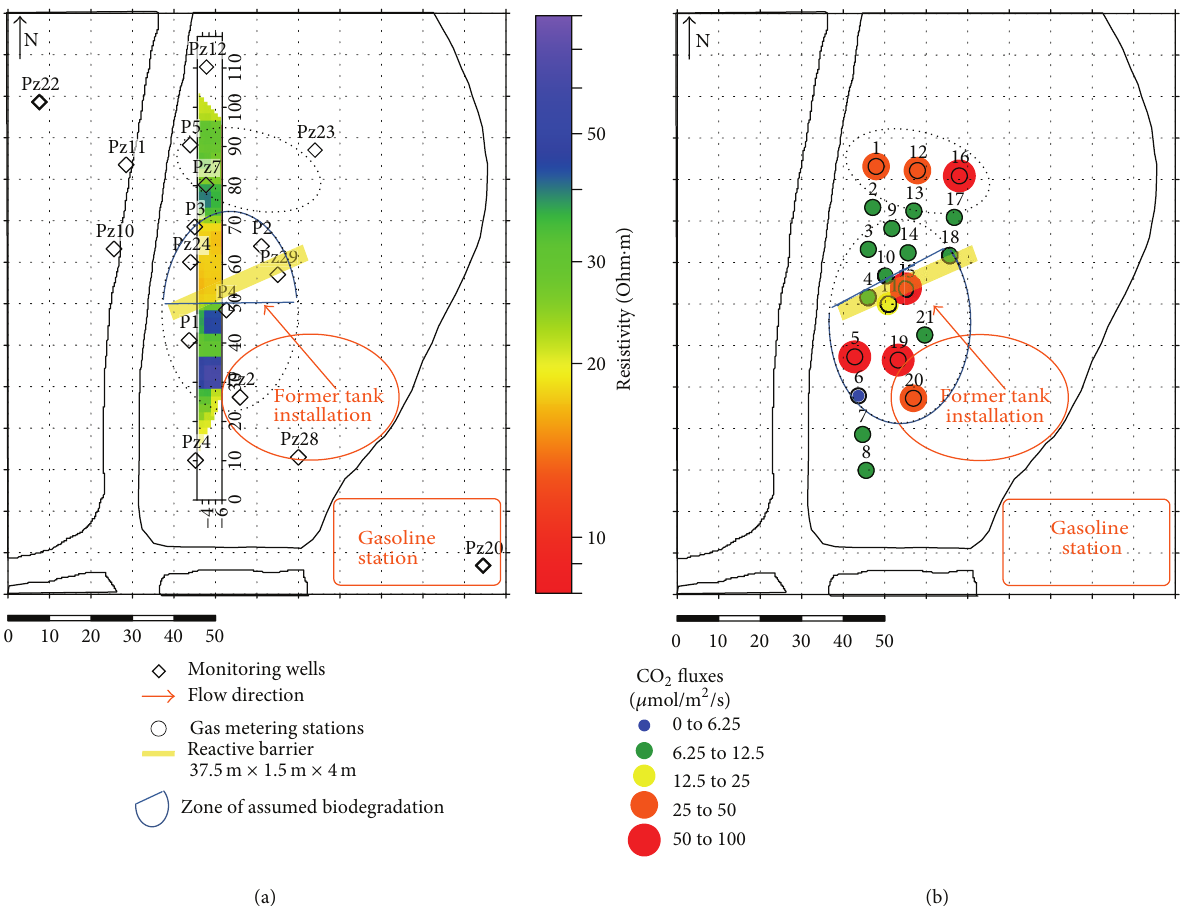
Figure 13: Maps of electrical resistivity measured on the permanent profile (a) and of measured CO 2 emissions (b), in July 2014. The elliptical shape highlights the area of biodegradation with production of conductive metabolites and CO 2